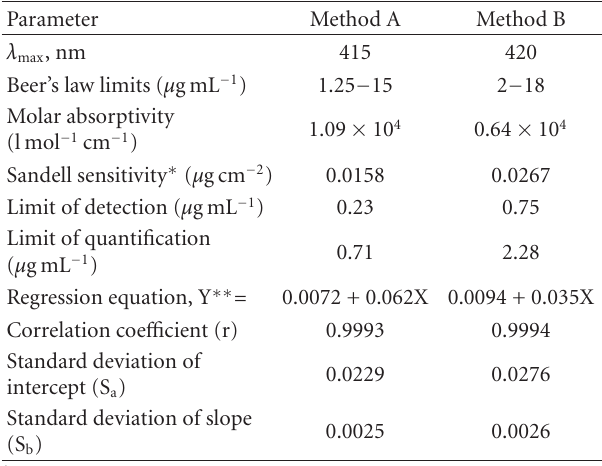
Table 3: Regression and analytical